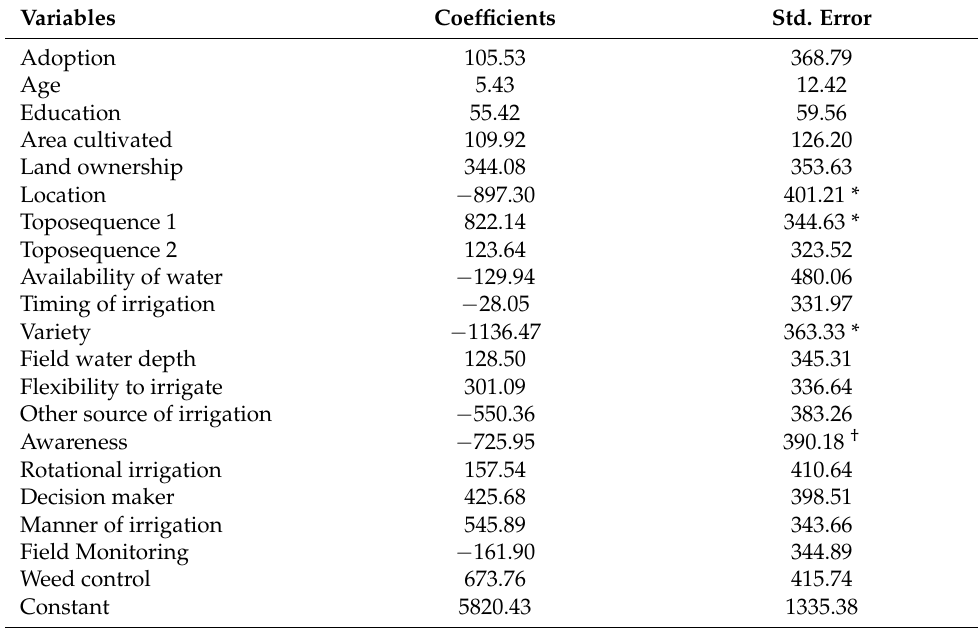
Table 6. Determinants of yield (N = 163).